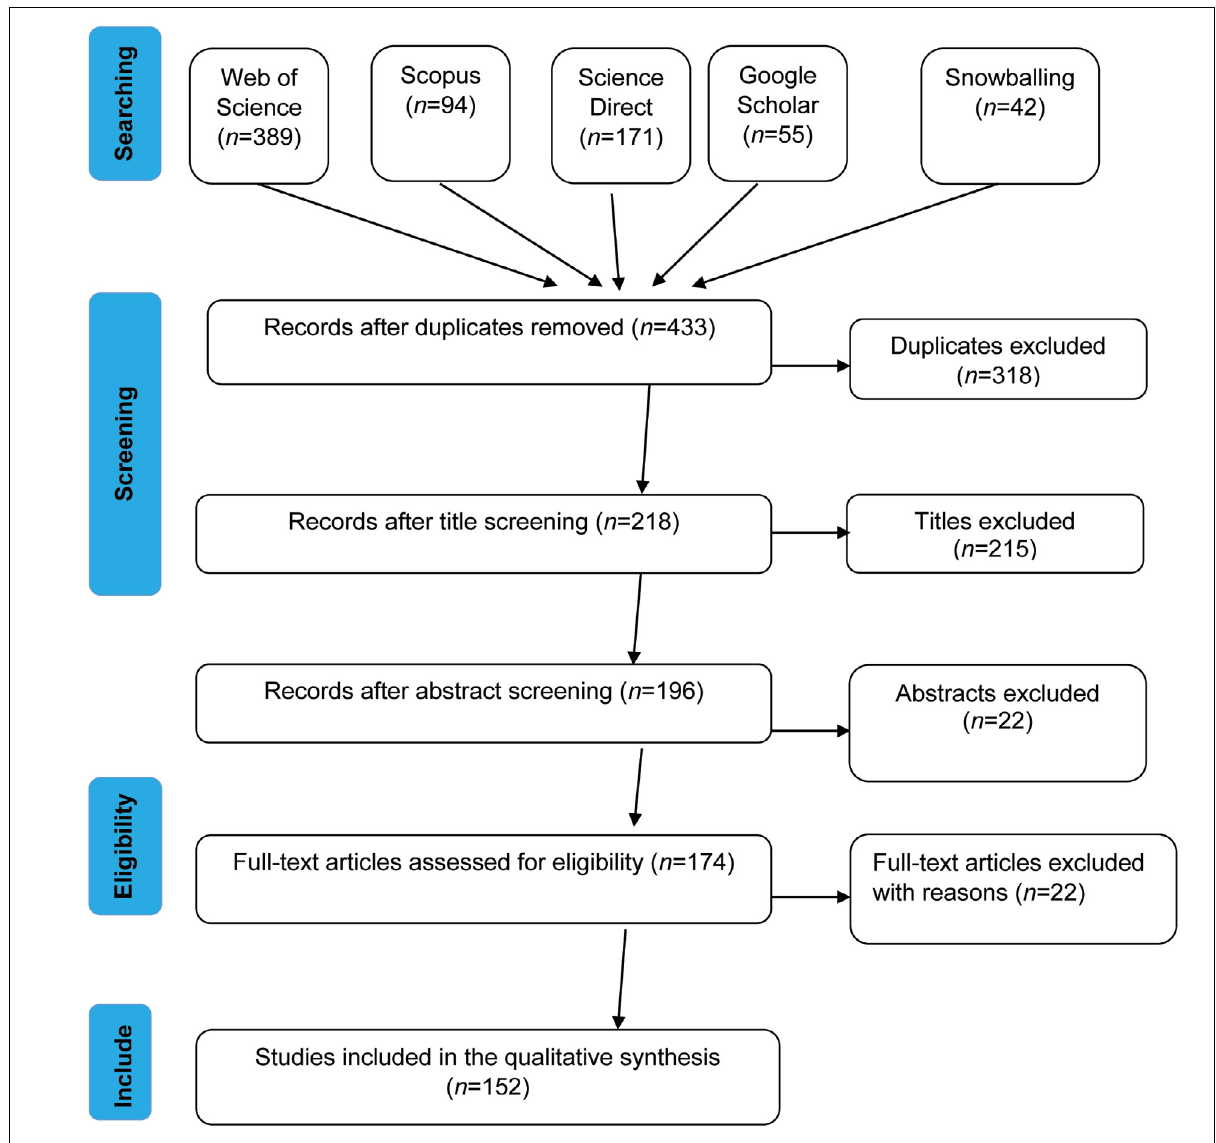
Figure 1: PRISMA diagram sketching the results of articles at searching and screening phases from different databases and